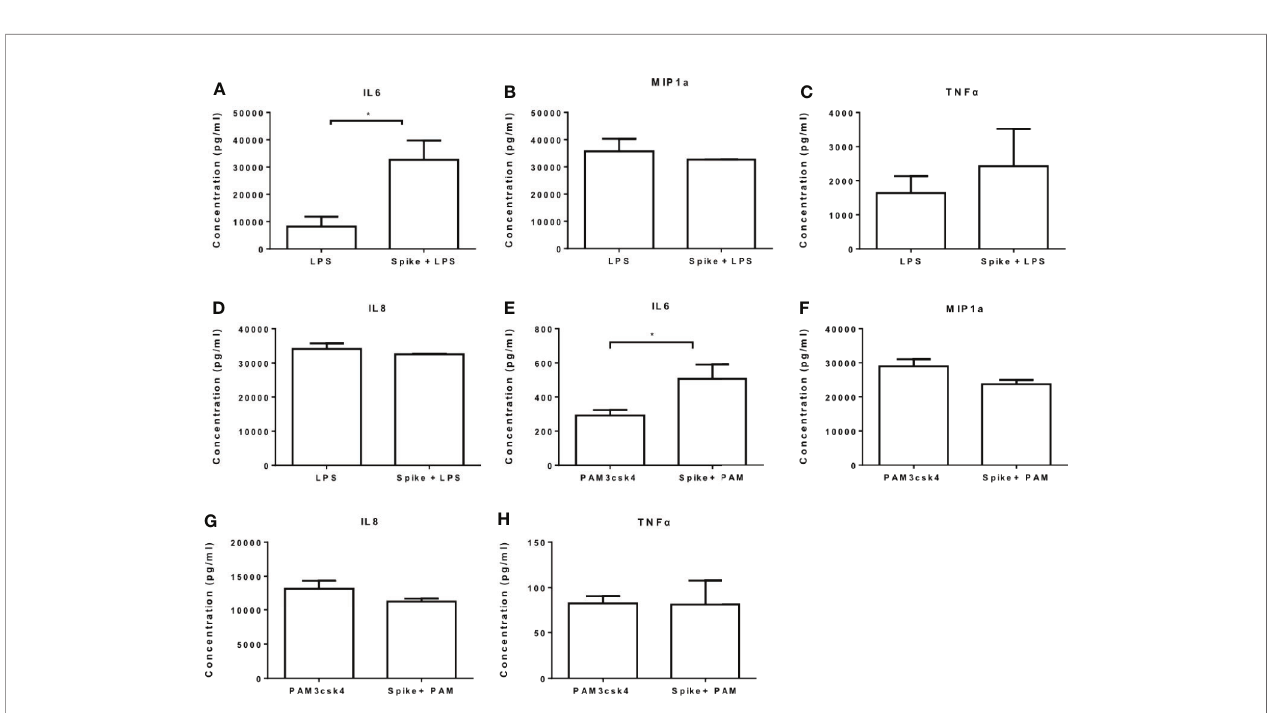
FIGURE 4 | SARS-CoV-2 S protein increased secretion of LPS and PAM3csk4-induced IL6. THP-1 macrophages were treated with 50ng/ml SARS-CoV-2 S protein and LPS or PAM3csk4 for 12 hours and their supernatants were collected for protein quanti fi cation using ELISA. (A) Increased LPS-induced IL6 in the presence SARS-CoV-2 S protein, (B – D) No effect observed for LPS-induced MIP1a, TNF a and IL8 secretion, (E) Increased PAM3csk4-induced IL6 secretion, (F – H) No effect observed for PAM3csk4-induced MIP1a, IL8 and TNF a secretion. Data are illustrated in bars and plotted as median with range. Statistical analysis was performed with Mann – Whitney U test. *p <